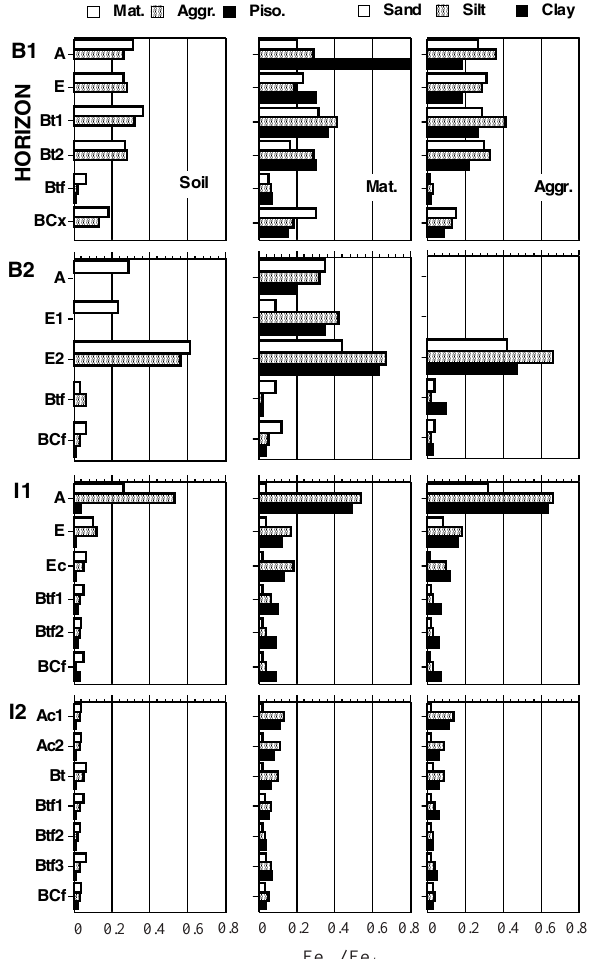
Figure 2. Ratio of Fe to Fe in each consistency o d fraction and in the particle size fractions of the matrices and water-stable aggregates. Note that the horizontal scale is identical for all graphs and the legend for consistency fractions applies only to graphs in the first